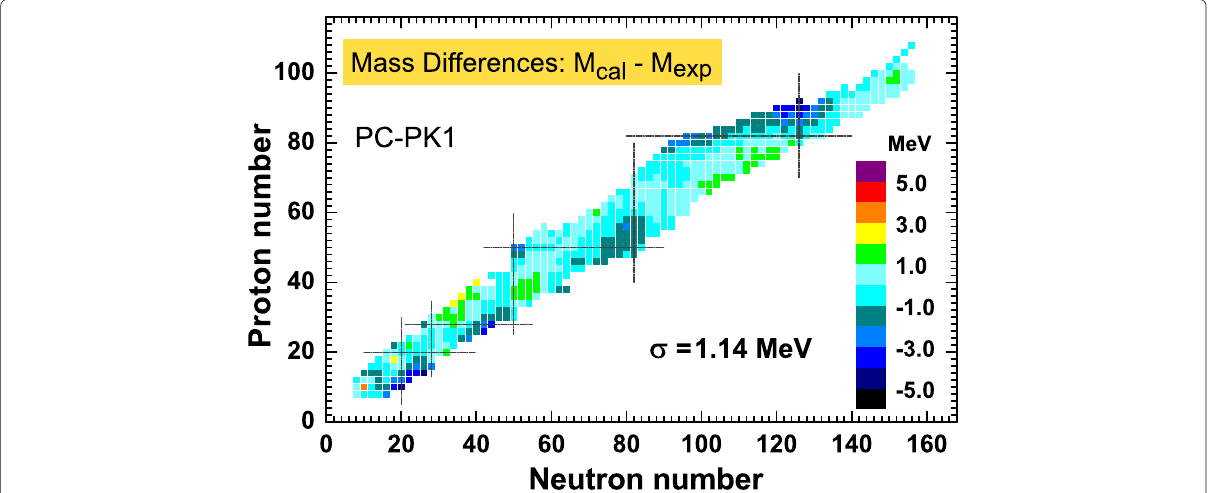
Fig. 2 (Color online) Mass differences between the PC-PK1 predictions and the data for 575 even–even nuclei [19]. The σ value represents the root-mean-square deviations between the theoretical predictions and data. Taken from Ref. [18]